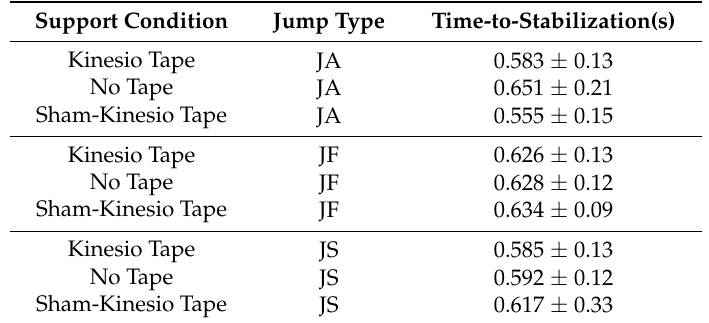
Table 3. Time-to-stabilization (M ± SD) by Support Condition and Type of Ballet